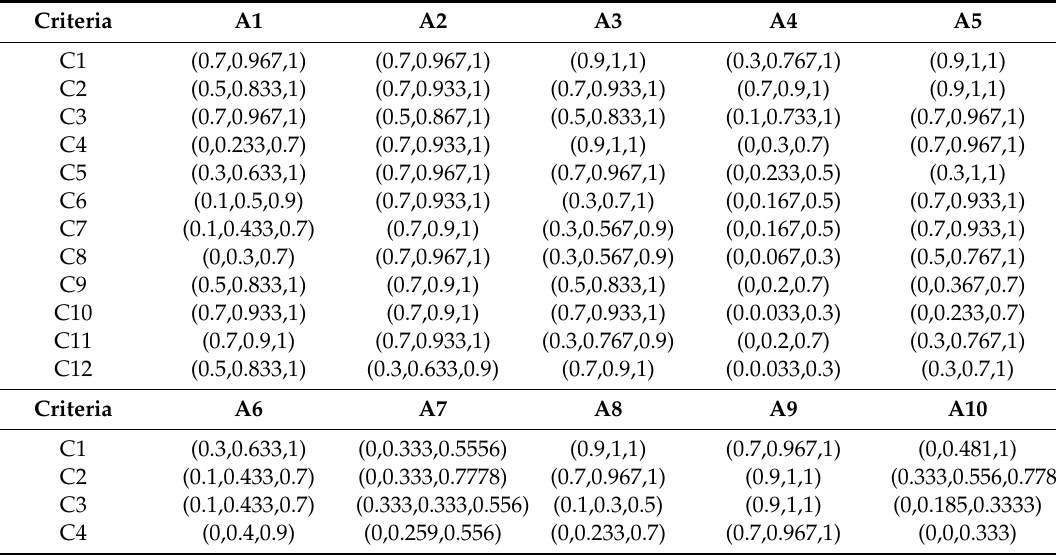
Table 12. Normalized fuzzy aggregated decision